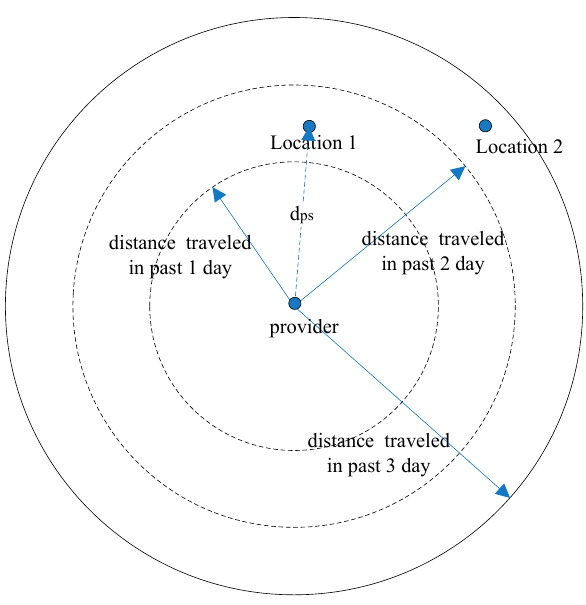
(1)}) , (cid:1839)(cid:1853)(cid:1876)({(cid:1856) (cid:3047)